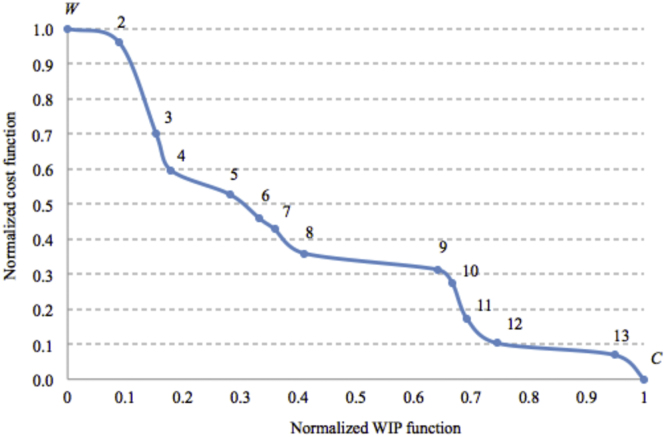
Normalized Pareto frontier [1].